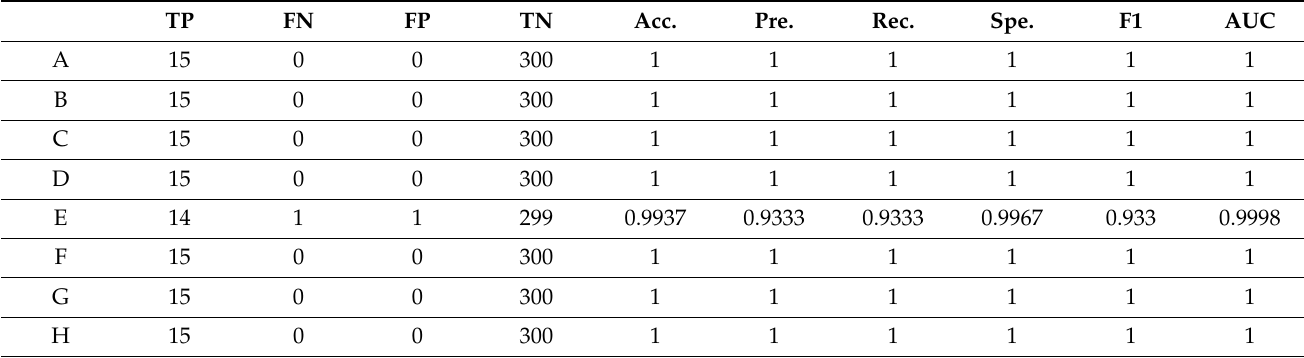
Figure 6. Cumulative confusion matrix for spherical features from cross validation with k = 15. Rows show the actual classes, and columns show the predicted classes. The confusion matrix ( i , j ) displays the total numbers of test examples with the actual class i and predicted class j . Table 3. Numbers of false negatives (FN), false positives (FP), true negatives (TN), and true positives for each class from the confusion matrix for spherical features in Figure 6. For each class, the metrics of accuracy (Acc.), precision (Pre.), recall (Rec.), specificity (Spe.), F1 score, and area under the curve (AUC) of the received operating characteristic (ROC) are computed. The last row E(.) displays the average for each column.